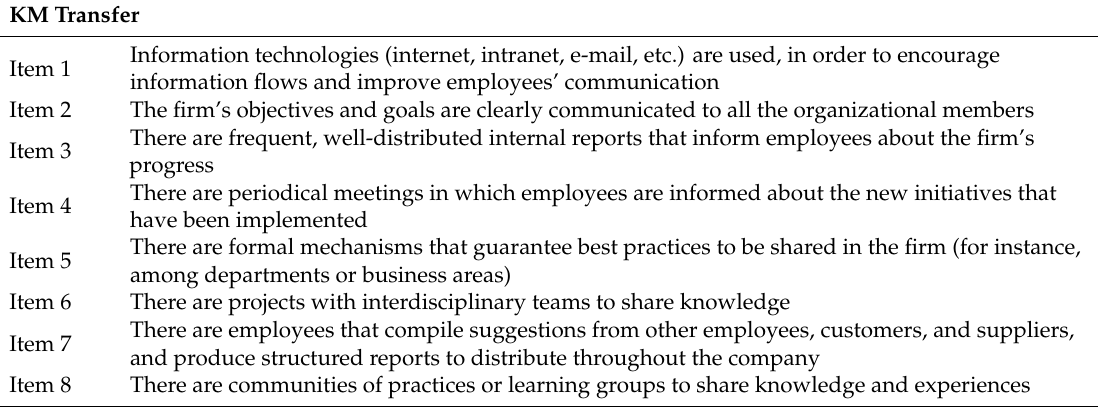
Table A1. Knowledge Management